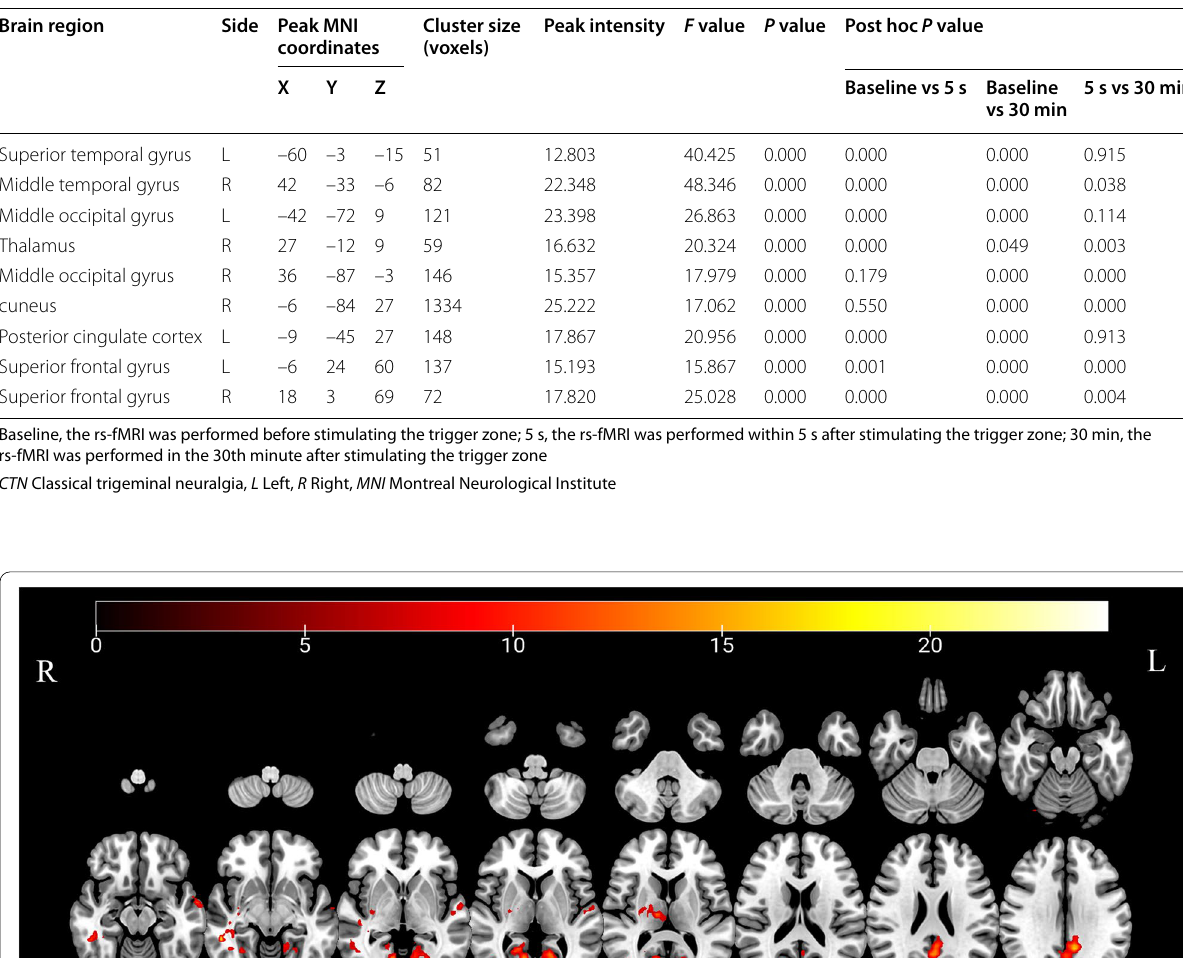
Table 2 Regions with static amplitudes of low-frequency fluctuations in patients with CTN